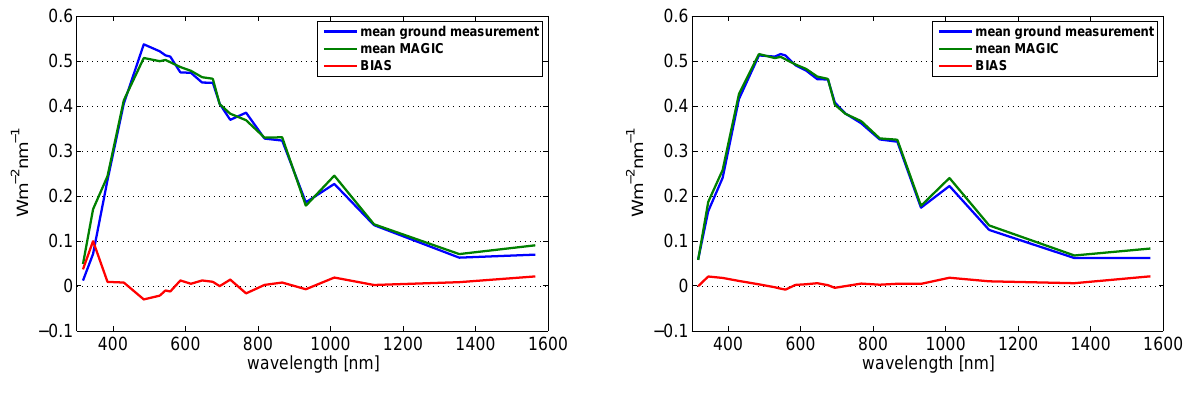
Figure 7. Average spectrum for Kato bands measured at Loughborough ( left ) and Stuttgart ( right ) in comparison with SPECMAGIC. The bias is given in